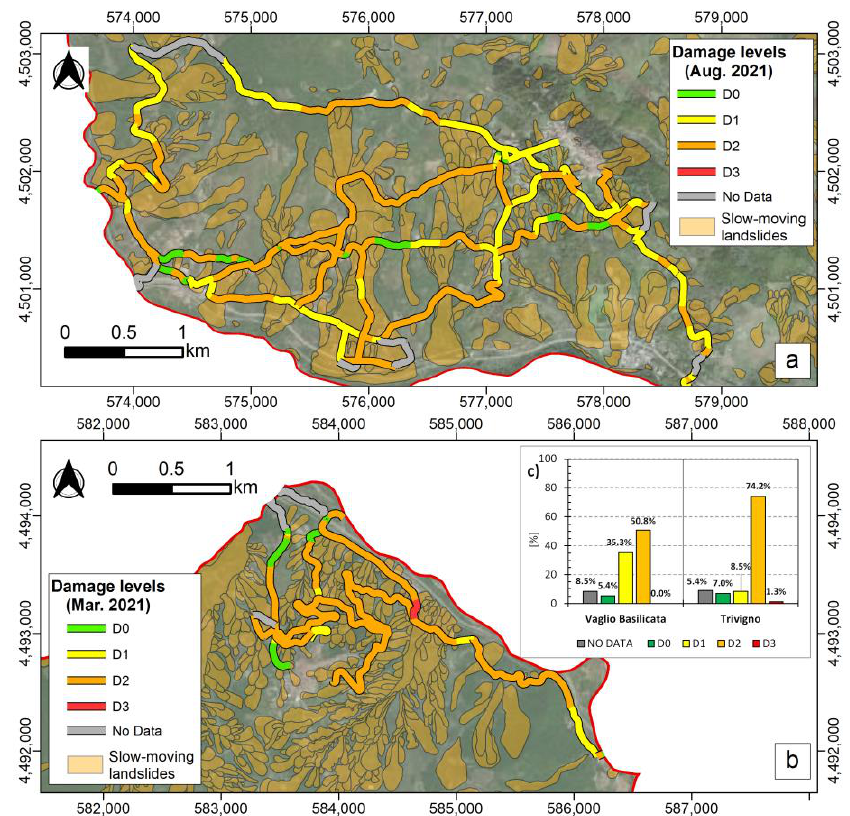
Figure 6. Maps of damaged road stretches with severity levels resulting from the damage classification using Google Street View imagery dated August 2021 for Vaglio Basilicata ( a ) and March 2021 for Trivigno ( b ). Percentages of damaged road distinguished according to the four (D0–D3) damage severity levels are also reported ( c ).